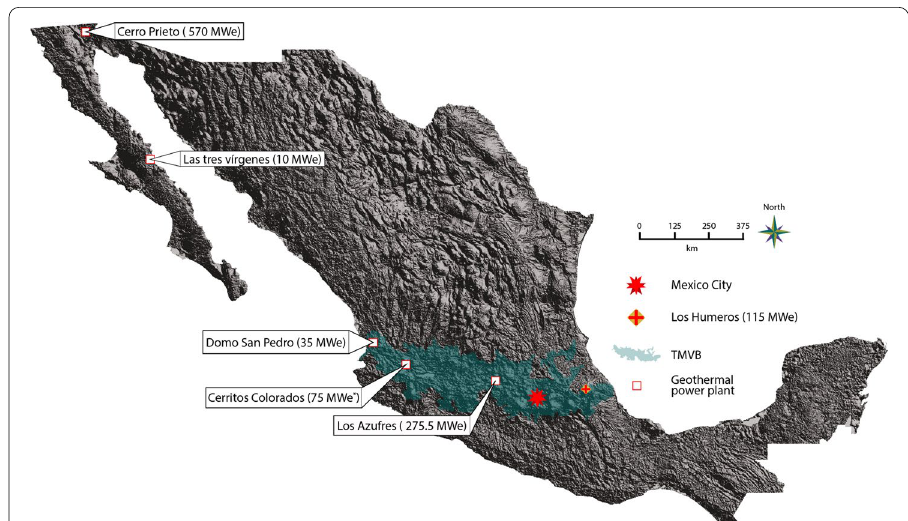
Fig. 1 Location of the Los Humeros, Mexico. Los Humeros caldera is located at the eastern part of the trans Mexican volcanic belt (Ferrari et al. 2012). Inside the TMVF are 2 more power plants under exploitation.